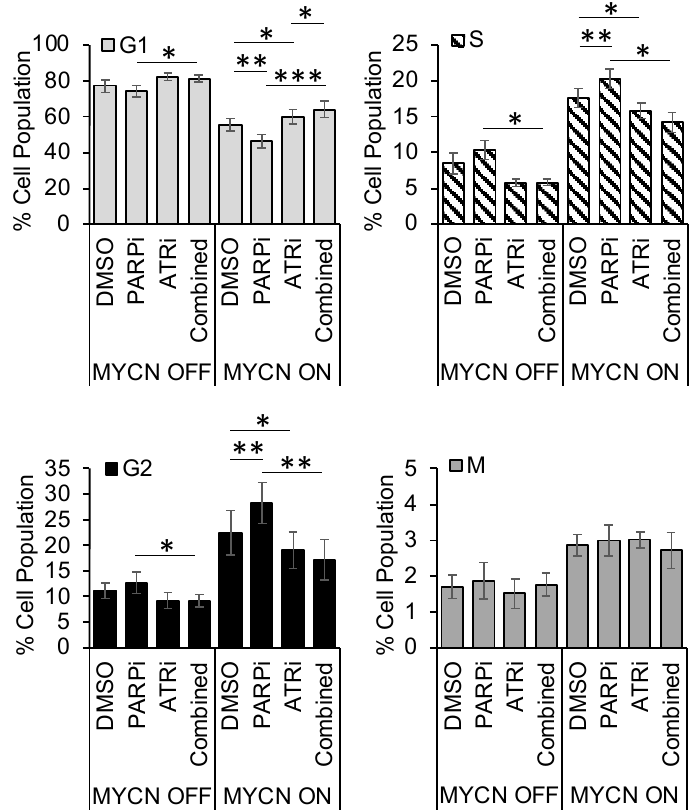
Figure 5. PARP inhibition induces accumulation of cells in S/G2, which is overcome by addition of an ATR inhibitor. Cell cycle profile of SHEP-Tet21/N cells with MYCN ON and MYCN OFF 24 h post treatment 0.5 µ M VE-821 and or 0.5 µ M Olaparib or DMSO control, mean and SEM of 5 independent repeats each representing 10,000 cells. Statistical significance was calculated using Student’s t -test (means). Throughout *, ** and *** represent p < 0.05, <0.01, and <0.001 respectively.